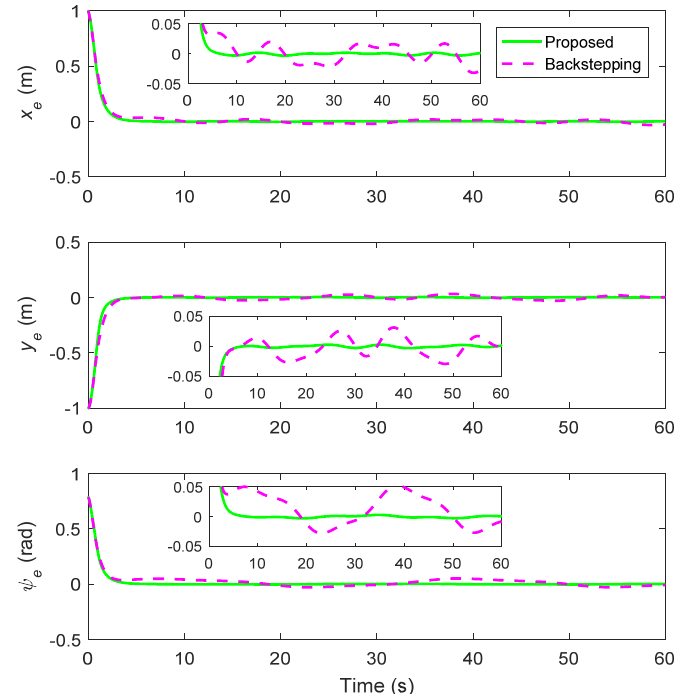
Figure 14. Pro fi le of the position tracking errors (Case 2).